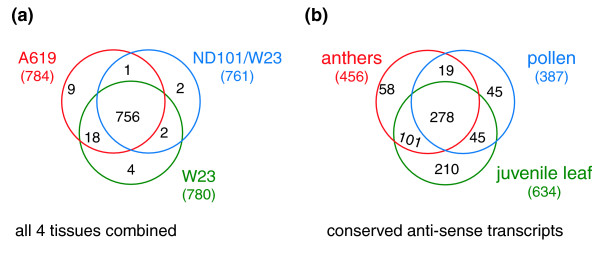
Distribution of antisense transcripts. (a) Global analysis of antisense transcripts in all four tissue samples combined. (b) Tissue analysis of the 756 antisense transcripts conserved in all three lines, after pooling data for the two anther stages into one collection.